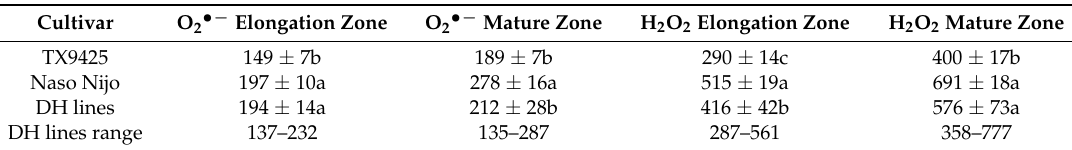
Table 1. Reactive oxygen species (ROS) production in the elongation and mature zones of parents and DH lines under hypoxia (0.2% agar) stress. ROS concentrations was measured in relative units (see Section 4). Data are mean values ± SE. Data labelled with different low-case letters is significant at p < 0.05.